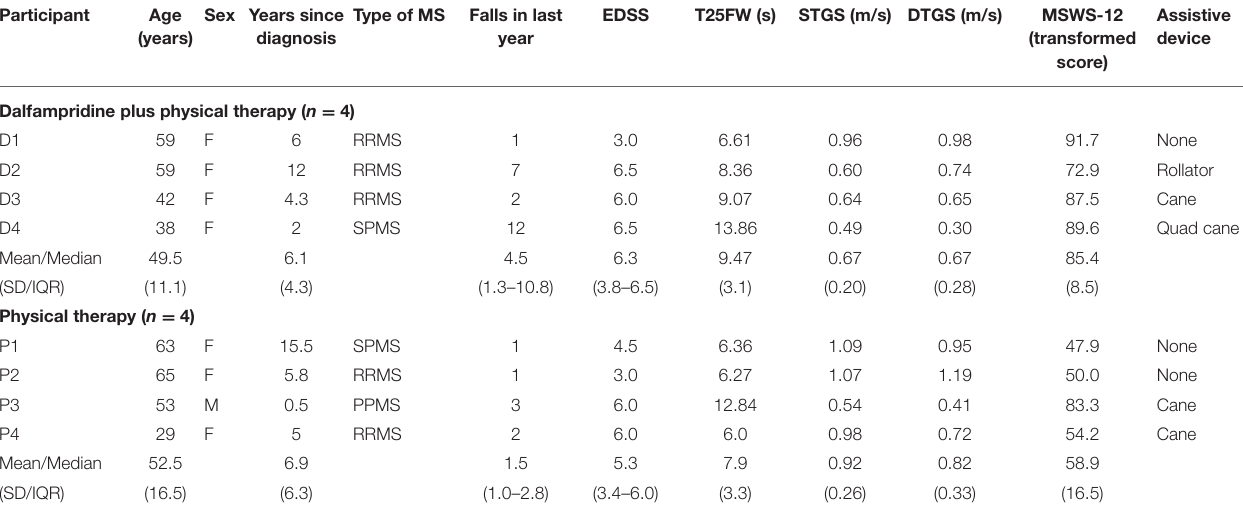
TABLE 1 | Demographic and baseline characteristics of participants in each group. Participant